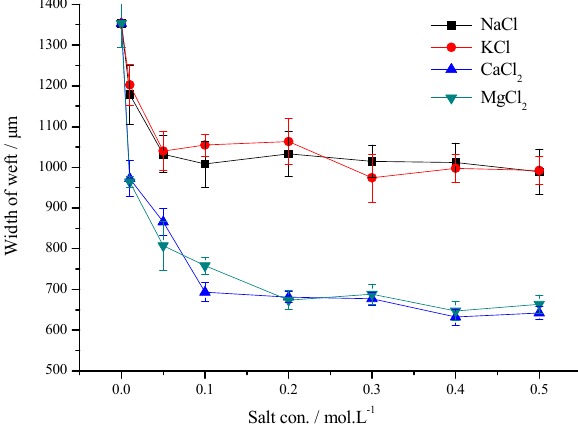
Figure 5. Effect of salt concentration on the width of warp printing direction. Figure 5. E